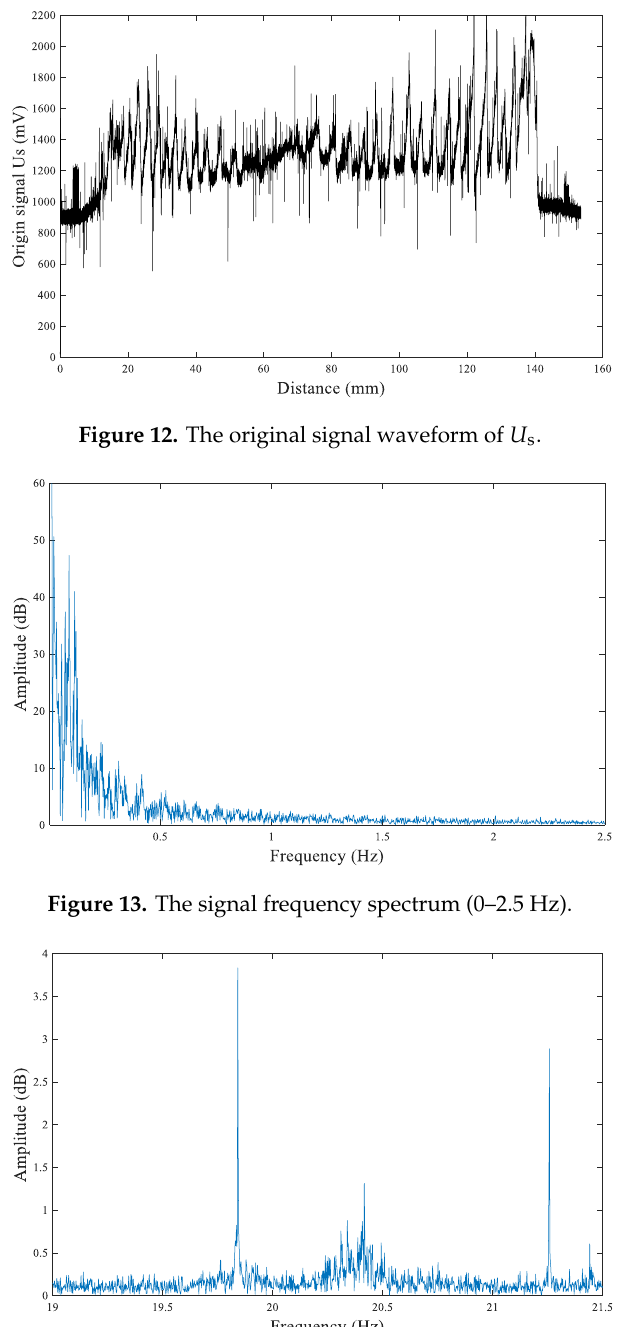
Figure 11. The operation of the microdestructive tree-ring measurement system.